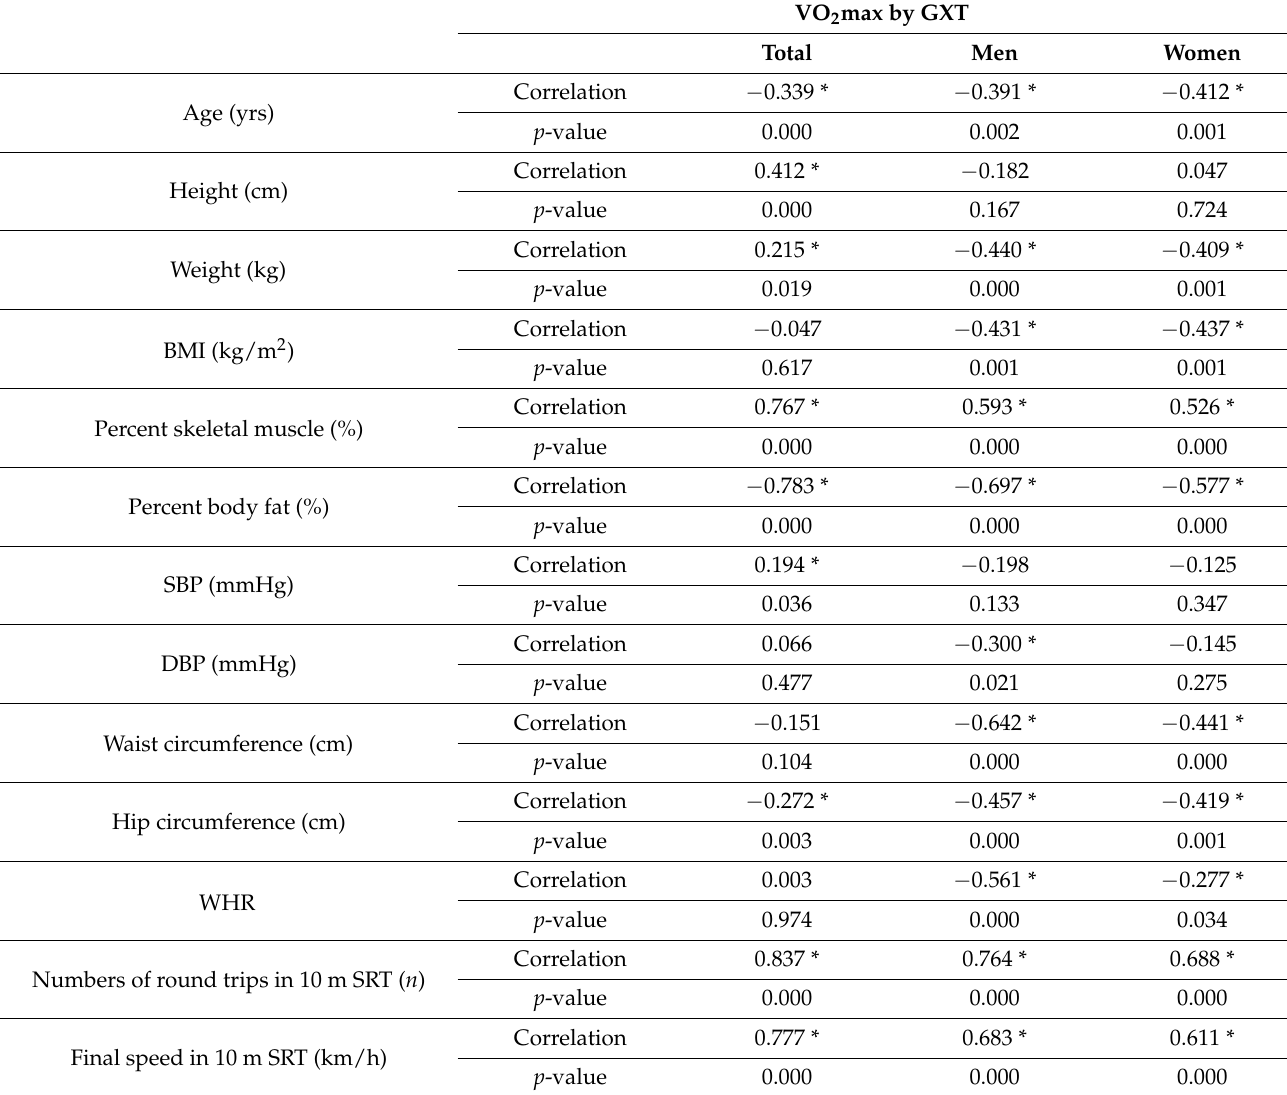
Table 3. Correlation between dependent variables (input data) and measured VO 2 max by GXT (output data).